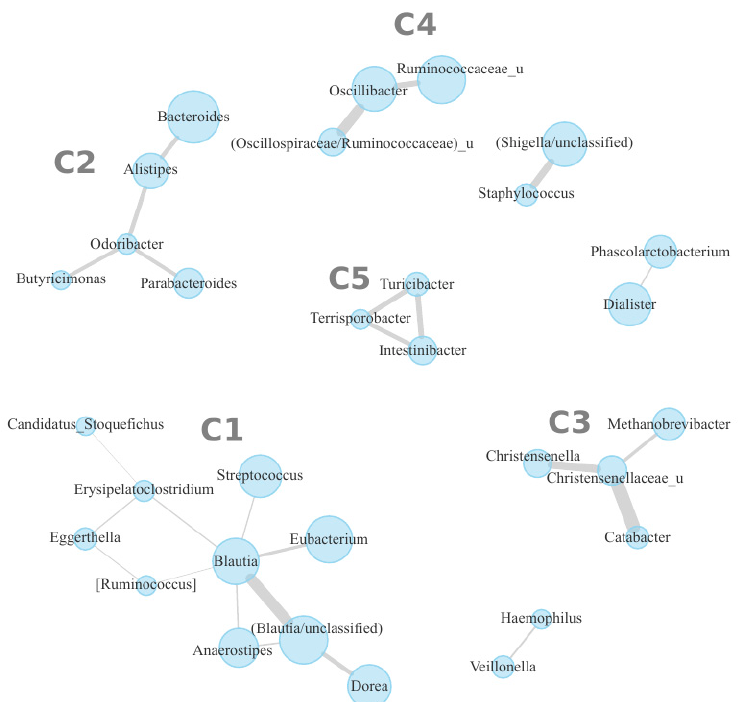
Figure 1. Co-occurrence graph of microbial genera in the samples of the volunteers. Vertices denote the genera; the size of each vertex is proportional to the average abundance of the genus across all samples. The thickness of edges is proportional to the absolute value of correlation coefficient. The “_u” postfix denotes all unclassified genera from the respective family. C1–C5 denotes cooperatives # 1–5, respectively.